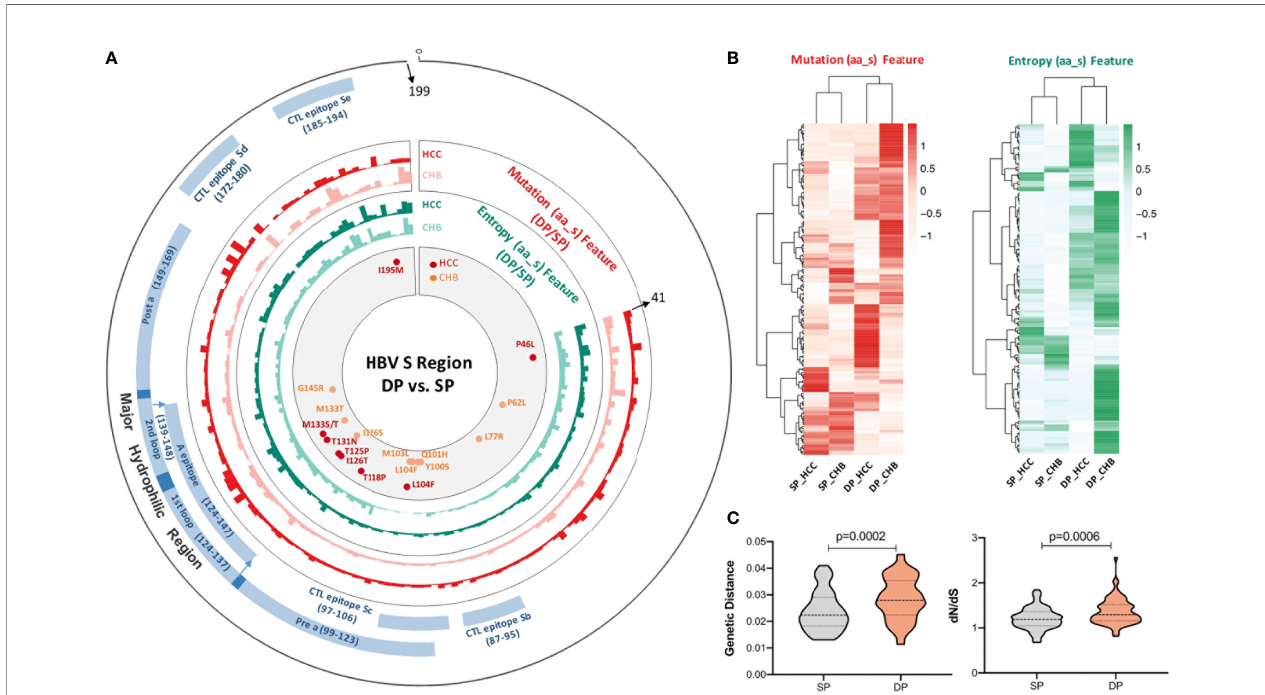
FIGURE 1 | The complexity and diversity of HBV s region between double-positive (DP) and single-positive (SP) patients in chronic hepatitis B (CHB) or hepatocellular carcinoma (HCC) patients. (A) The outermost circle represents the location of each functional region of the HBsAg protein (s41 – 199). The important functional HBV s region distribution was marked as blue and as follows: major hydrophilic region (MHR, s99 – 169) overlap of Pre a (s99 – 123), 1st loop (s124 – 137), A epitope (s124 – 147), 2nd loop (s139 – 148), and Post a (s149 – 169); CTL epitope Sb (s87 – 95), CTL epitope Sc (s97 – 106), CTL epitope Sd (s172 – 180), and CTL epitope Se (s185 – aa194). The colored histograms in the second and third circles indicate the complexity of mutation feature (dark red, HCC; light red, CHB) and entropy feature (dark green, HCC; light green, CHB) for each amino acid, respectively. The histogram value represents the feature ratio of DP to SP. The innermost circle shows the differential high-frequency mutations between DP and SP groups for both CHB (orange) and HCC (red) patients, respectively. (B) Different HBV s region features among SP_HCC, SP_CHB, DP_HCC, and DP_CHB groups by hierarchical clustering. The value in the clustering map represents the mutation (red, left) and entropy (green, right) features of each group. A correlation was used for the sample measurement, Euclidean distance for the feature measurement, and ward.D2 algorithms for the clustering method. (C) Different HBV s region quasispecies characteristics between SP (gray) and DP (orange) patients using MEGA X. The y-axis of the left violin plot represents the number of genetic distance (d), and the right represents the ratio of non-synonymous substitutions per non-synonymous site (dN) to the number of synonymous substitutions per synonymous site (dS). Statistical signi fi cance was evaluated using the unpaired Wilcoxon